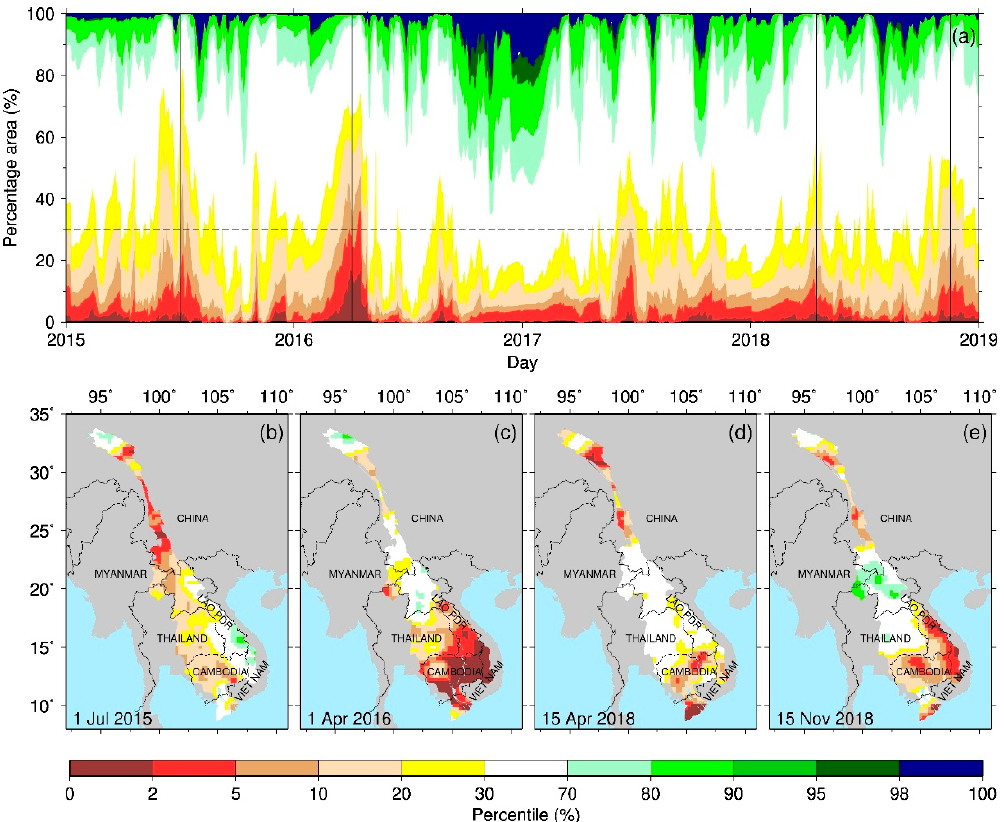
Figure 11. The LMDM’s operational mode from 1 January 2015 to 31 December 2018. ( a ) Percentage area within a percentile range; for example, the red band indicates the fraction of total LMR region for which the SM percentile on a given day falls into the interval of 2%–5%. ( b – e ) SM percentile pattern on the representative dates with significant droughts indicated by the vertical lines in Figure 11a.